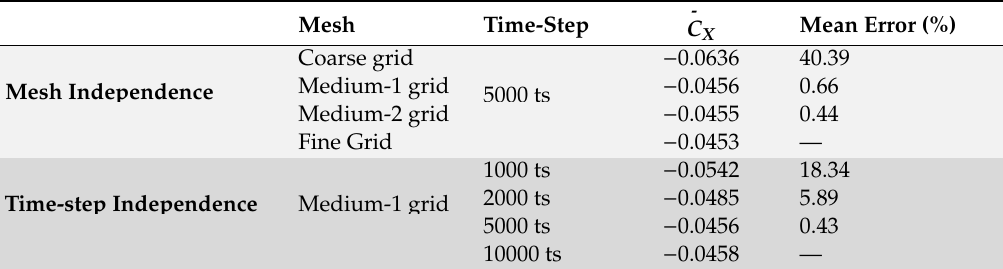
Figure 5. Evolution of the thrust coefficient for ( a ) the mesh independence study and ( b ) the time-step independence study for 𝑦 (cid:2868) = 0.2 , 𝑘 ∗ = 0.09 , and 𝑓 ∗ = 0.17 . Table 1. Mesh and time-step independence results. Table 1. Mesh and time-step independence results.